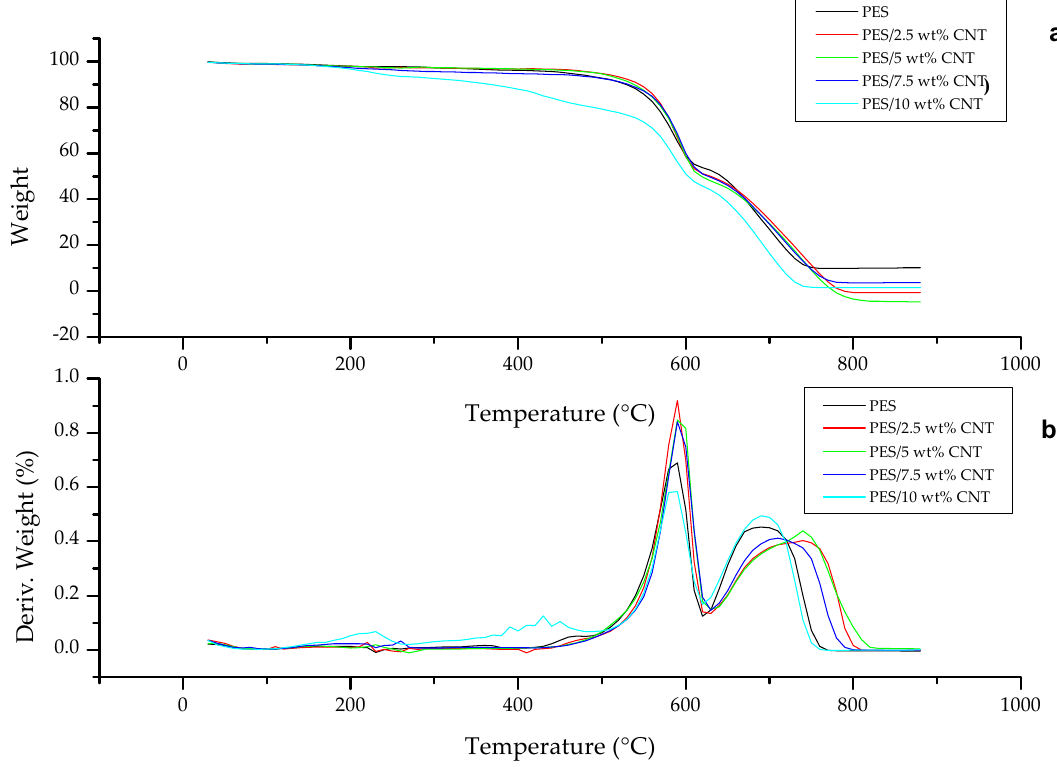
Figure 5. Thermal stability of PES and PES/CNT composites ( a ) Weight loss ( b ) DTA-derivative weight